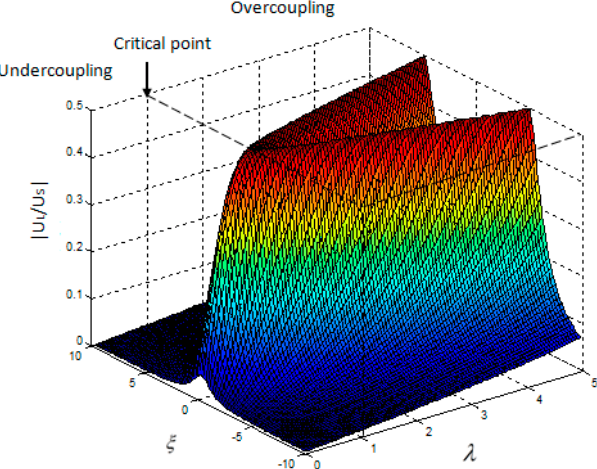
Figure 4. Normalized voltage-frequency response surface of a typical WPT system ( λ is the coupling factor, which indicates the tightness of coupling between the transmitter and receiver, and ζ is the detuning factor, which represents the degree to which the working frequency deviates from the resonant frequency).